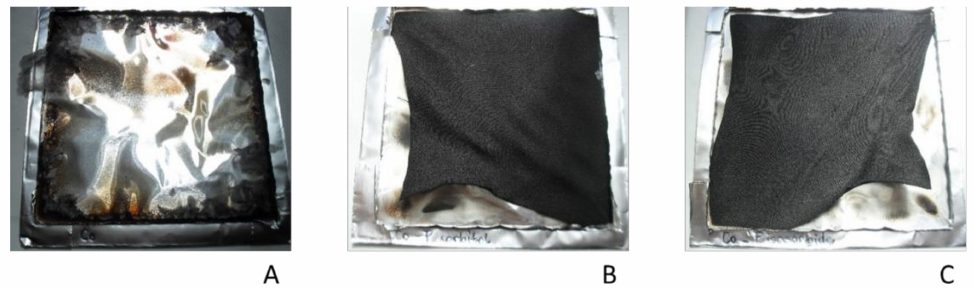
Figure 8. Comparison of untreated cotton ( A ) and Co-P-sorbitol ( B ) and Co-P-isosorbide ( C ) after cone calorimetry measurements.